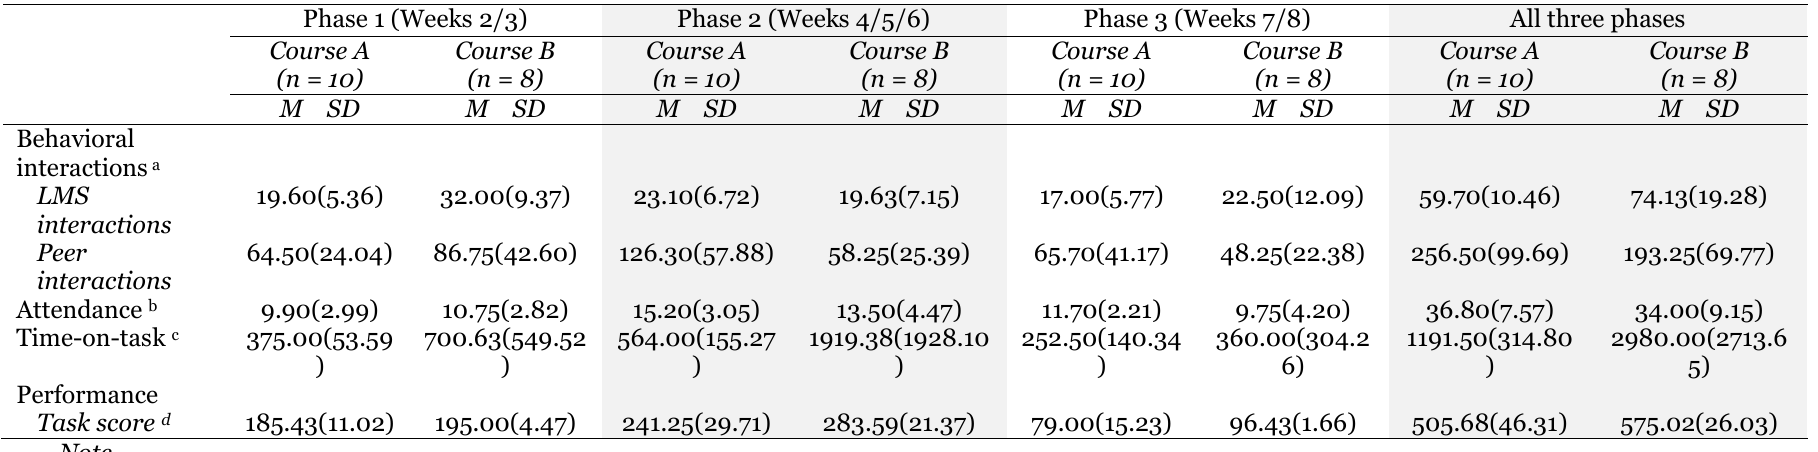
Descriptive Statistics of Behavioral Interactions, Time, Attendance, and